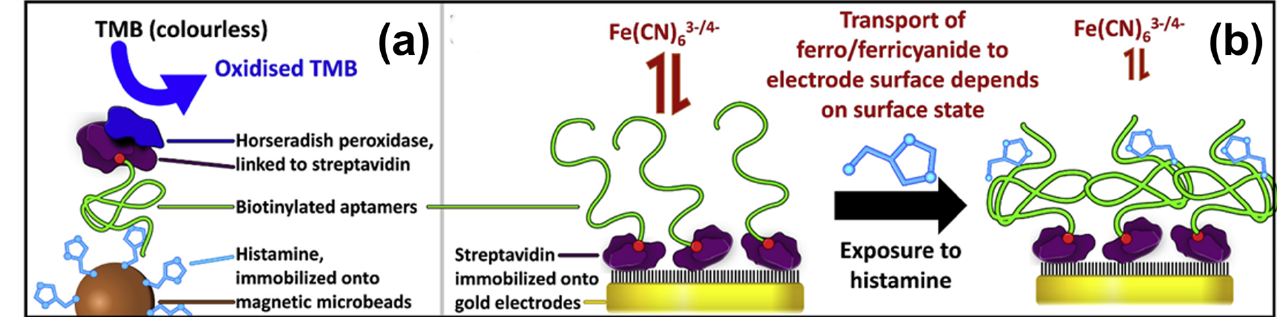
Figure 7. ( a ) Functionality testing of a histamine aptamer; histamine is tethered to magnetic beads while the biotinylated aptamer is linked to horseradish peroxidase HRP [131]. The aptamer-histamine binding is visualized in a colorimetric way through the enzymatic oxidation of TMB (tetramethylbenzidine) molecules by HRP. ( b ) Electrode design for impedimetric histamine detection with the aptamer immobilized on gold electrodes. Before binding of histamine, the electrode is accessible for the redox couple Fe(CN) 63 − /4 − , corresponding to a low impedance value. Upon recognition of histamine, the tertiary structure of histamine changes, resulting in a blocking of the electrode, which increases the charge-transfer resistance and the impedance value. Figure reprinted from ref. [131], Copyright 2020, with permission from